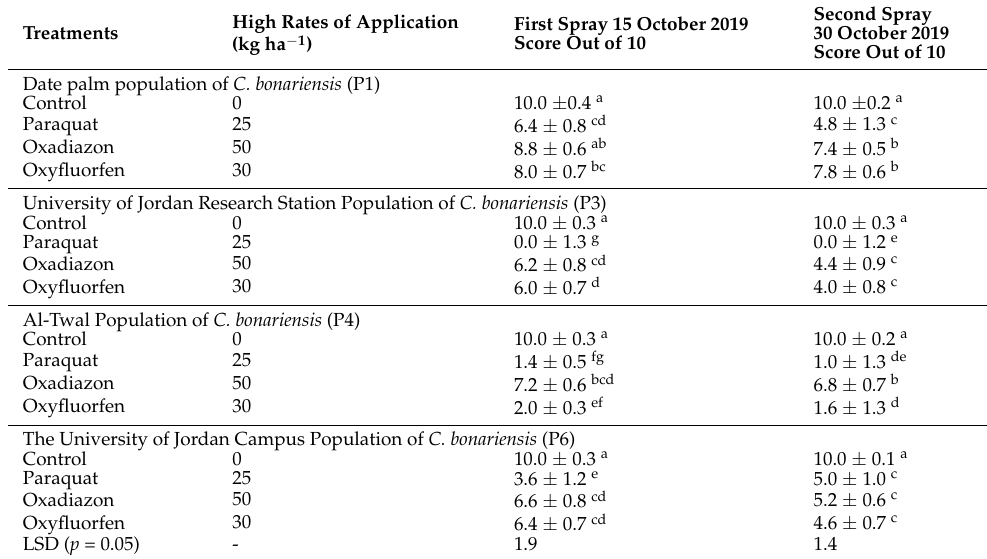
Table 5. The effect of high rate application of three herbicides sprayed at two dates at full vegetative growth stage of four populations of C. bonariensis grown in a pot experiment.